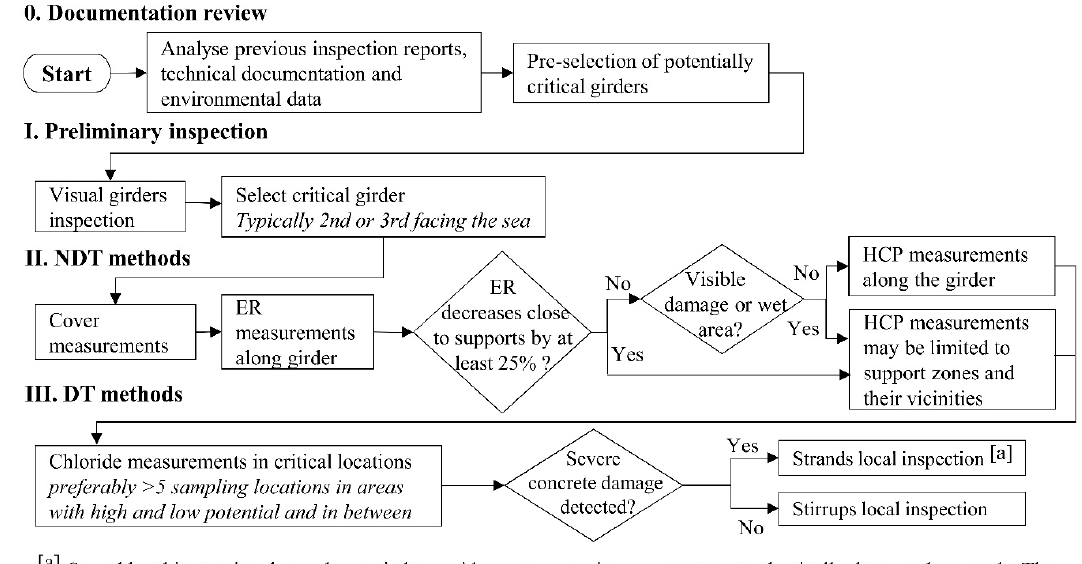
Figure 19. Procedure for detailed inspection of pretensioned bridge girders in a marine environment.